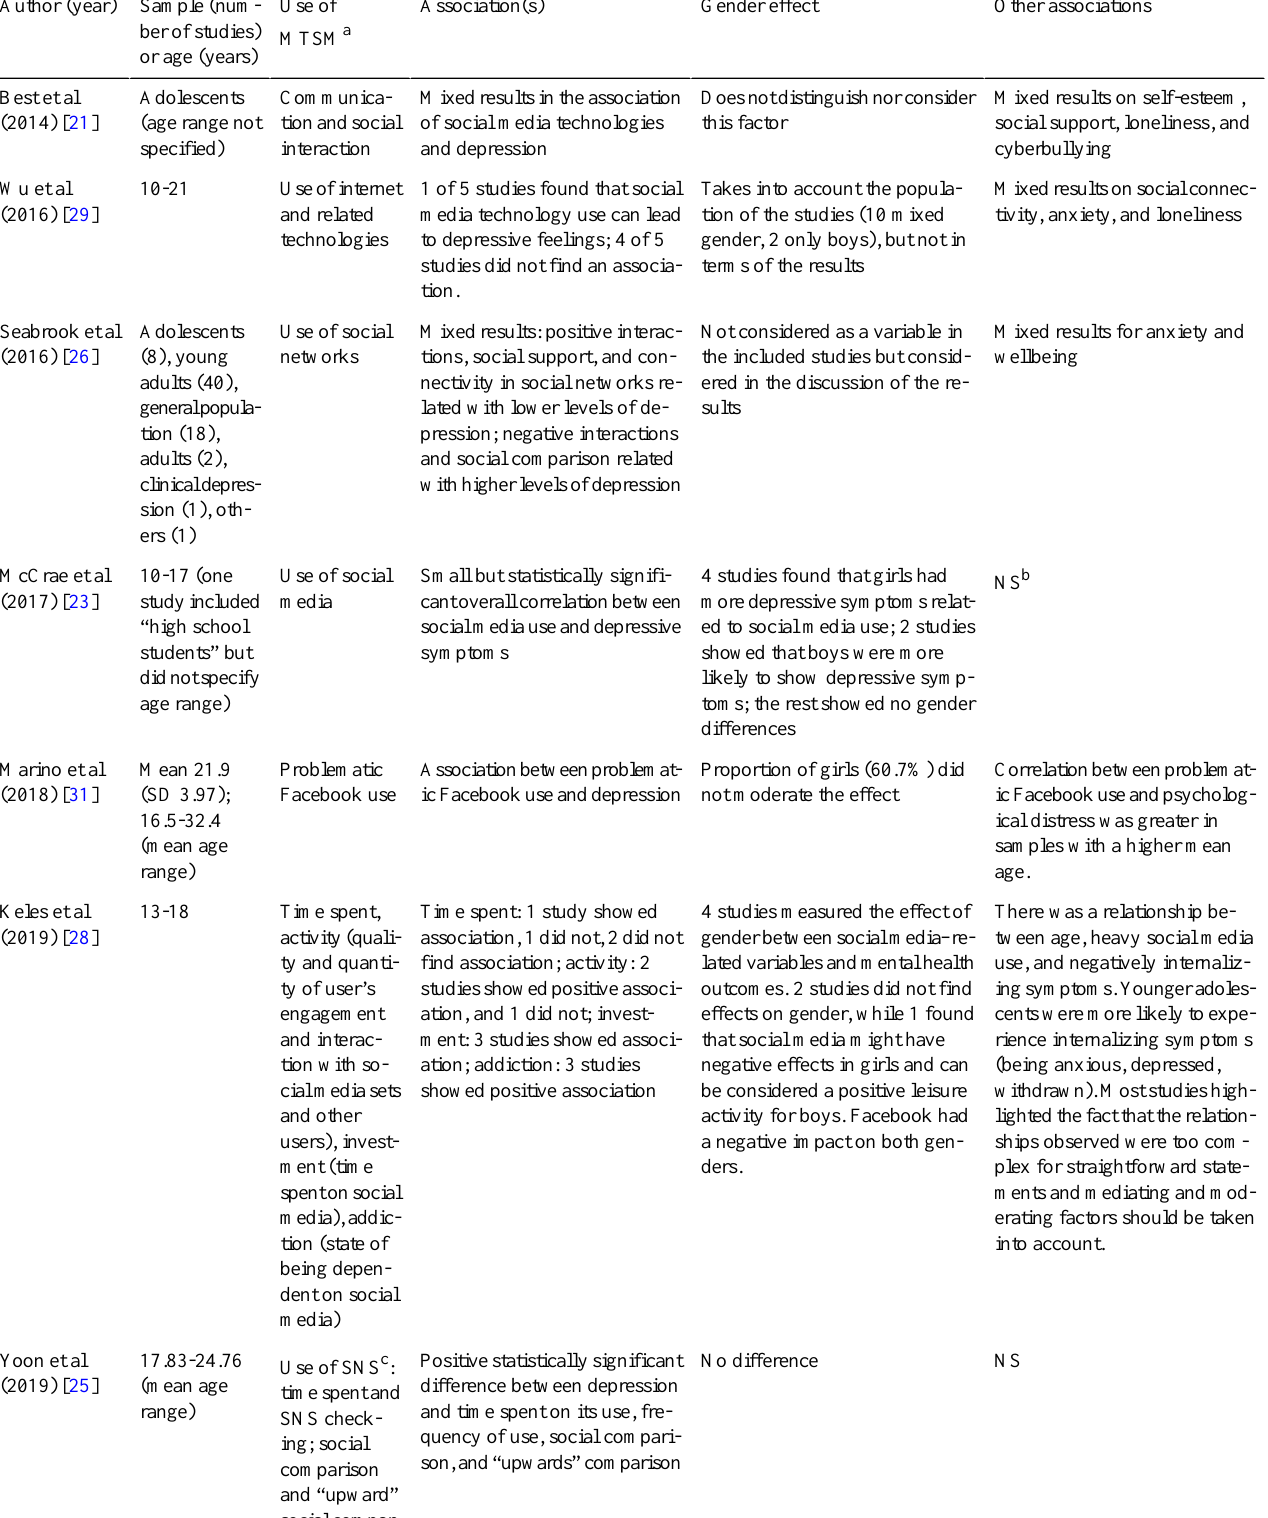
Table 2. Results of the included